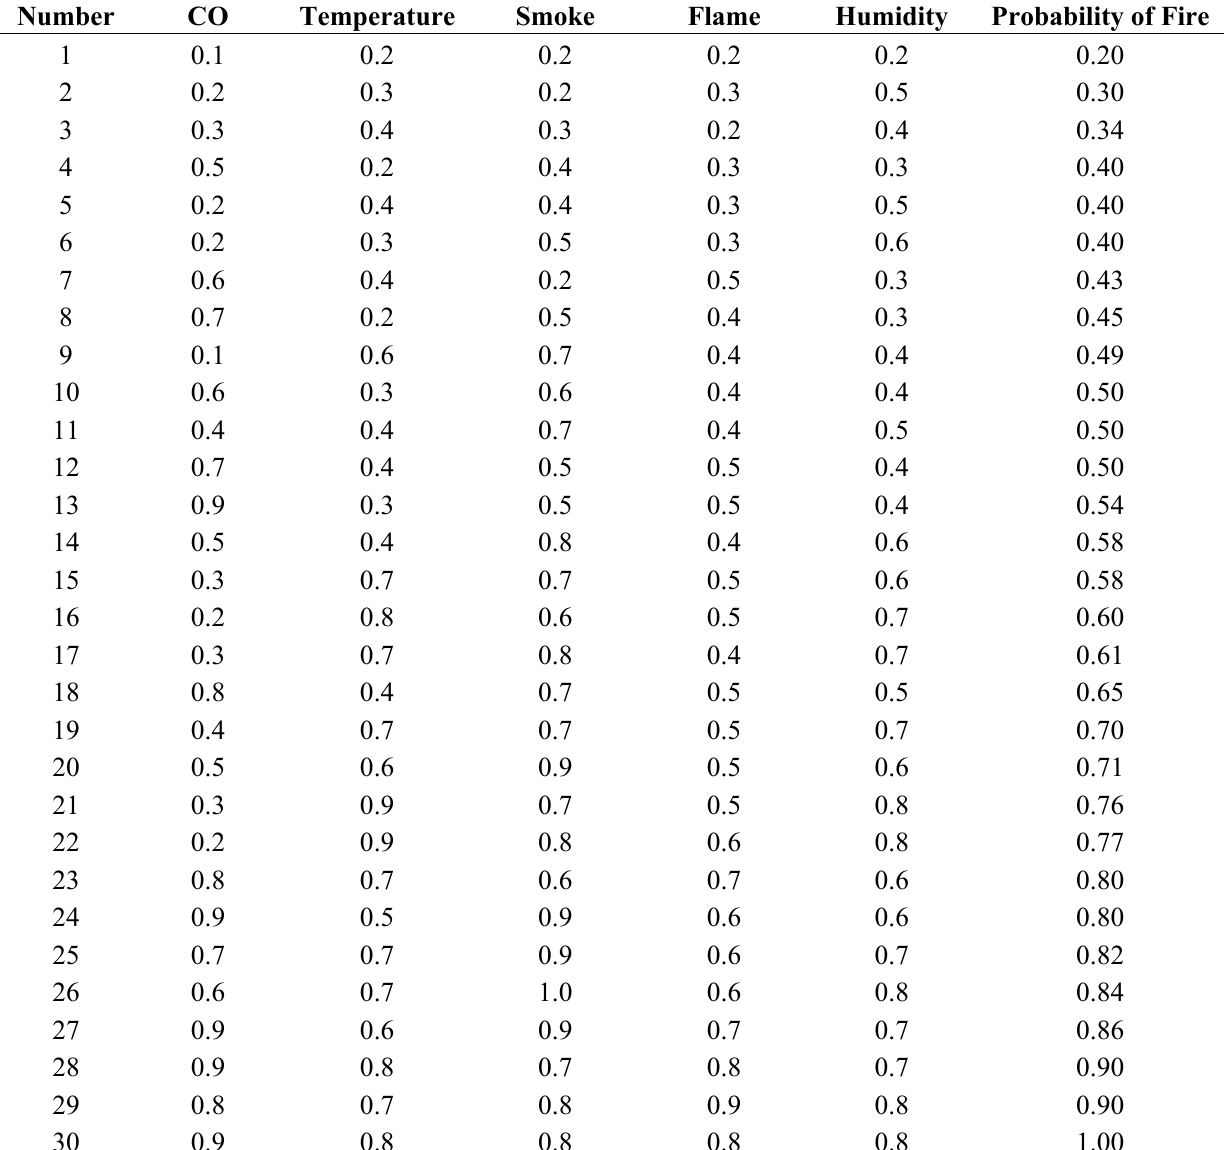
Table 1. Expert database for a multi-sensor intelligent fire monitoring system